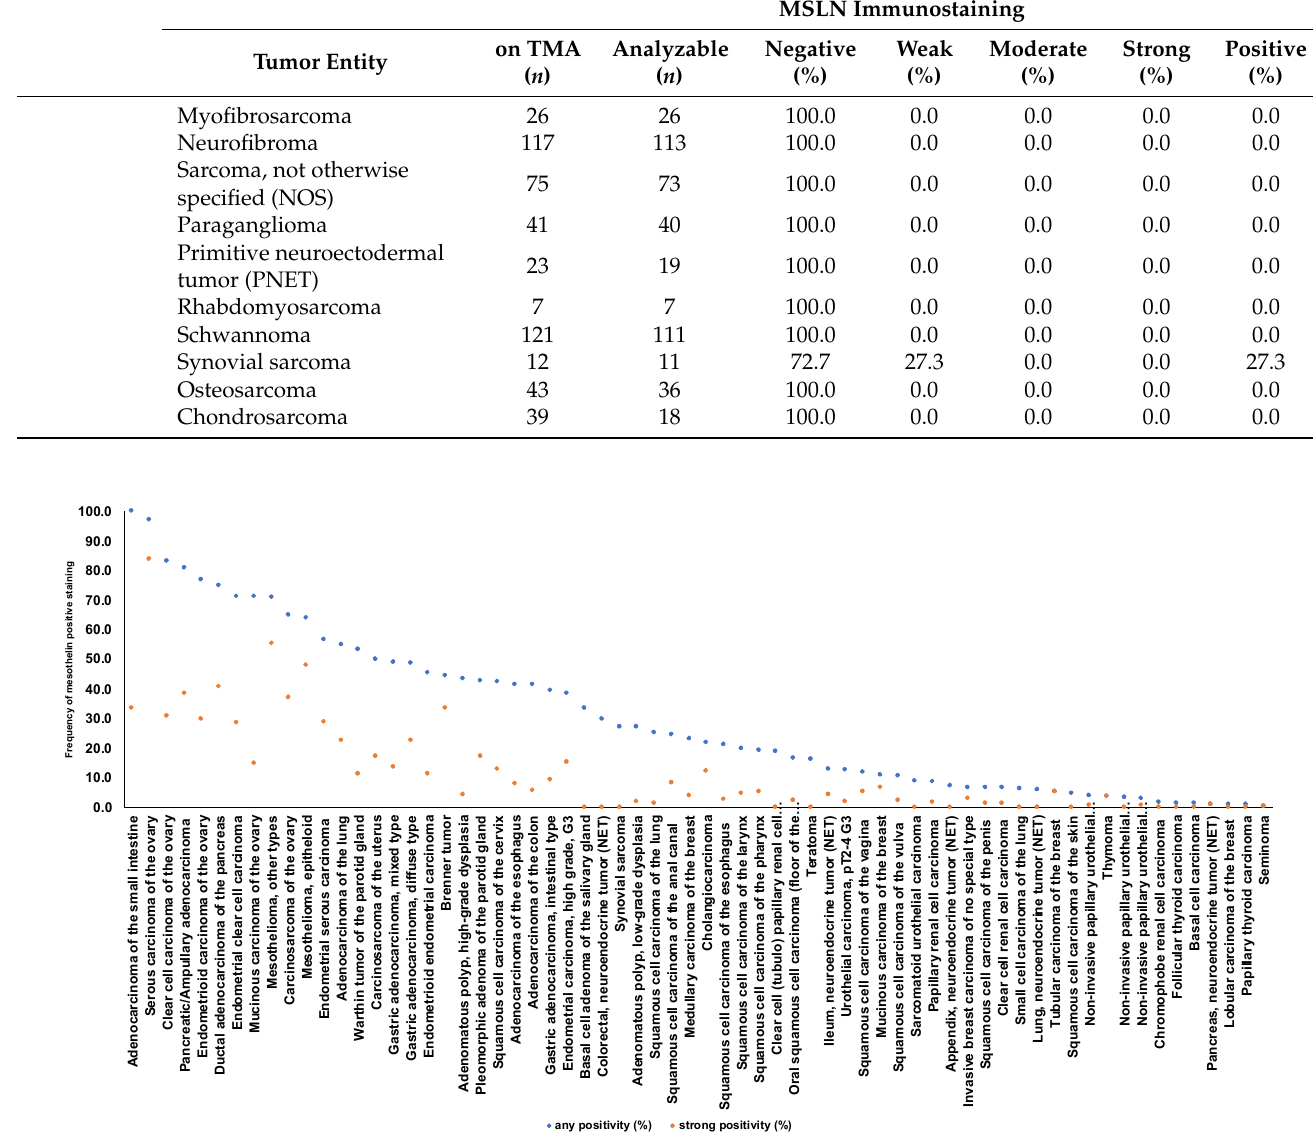
Figure 3. Ranking order of MSLN immunostaining in cancers. Both the frequency of positive cases (blue dots) and the frequency of strongly positive cases (orange dots) are shown. Fifty-six additional tumor entities without any MSLN positive cases are not shown due to space restrictions.